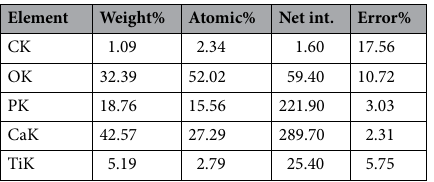
Table 2. Detailed elemental composition of S1.5 sample.